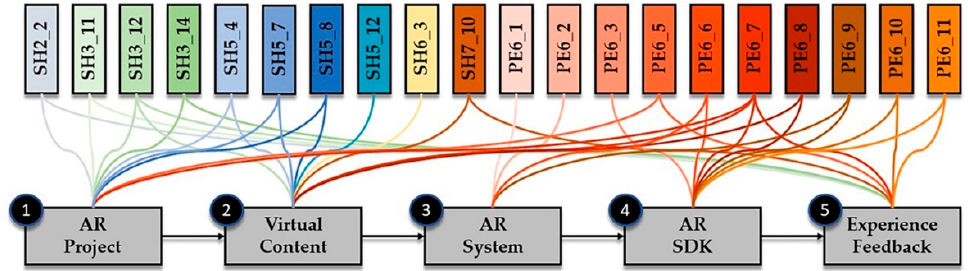
Figure 1. Diagram of the relationships between ERC sectors and the AR chain in the architecture domain.